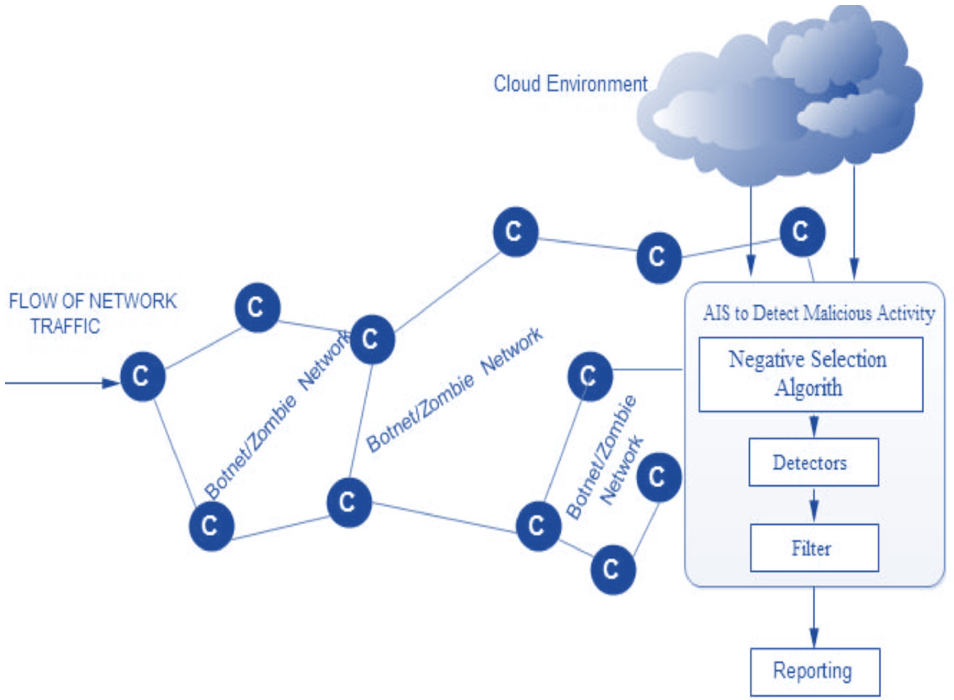
Figure 2. Flow Process of the cloud computing system.